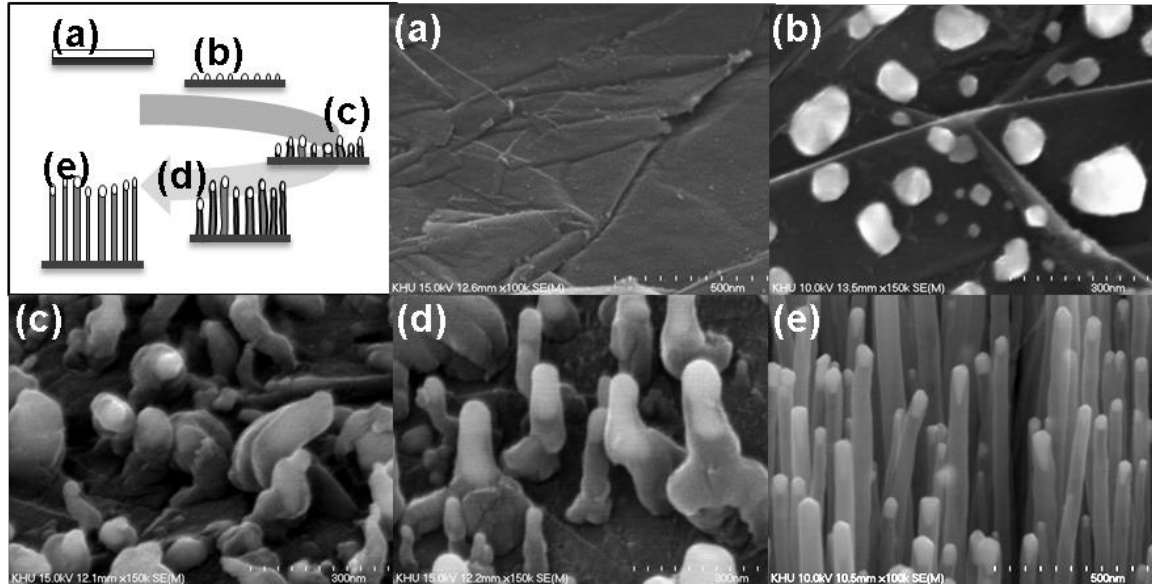
Figure 2. Schematic illustration and SEM images of growth mechanism of the all-carbon electrode. ( a ) bare graphite substrate; ( b ) aggregated Ni catalyst by forming